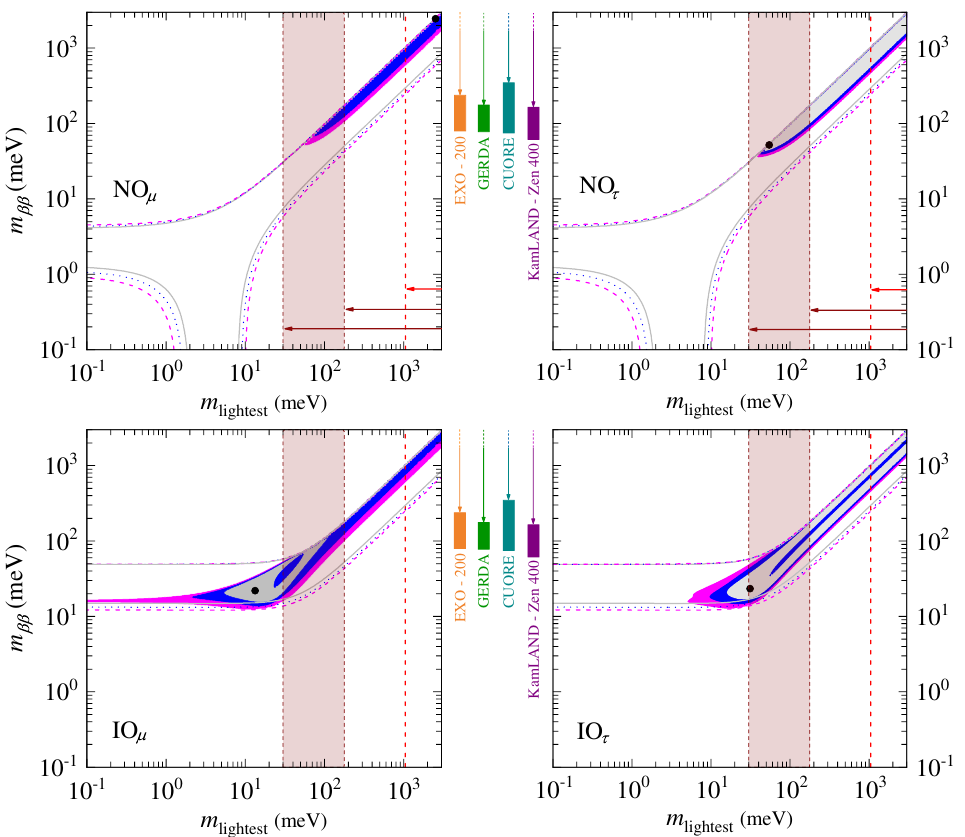
Figure 7 . Allowed ( m lightest , m ββ ) regions for NO (upper panels) and IO (lower panels). The colour code is the same in figures 5 and 6. The solid (dotted) [dashed] lines delimit the 1 σ ( 2 σ ) [ 3 σ ] m regions allowed in the general unconstrained case. The vertical bars in between the panels ββ indicate the current m upper bounds from KamLAND-Zen 400 [41], GERDA [42], CUORE [43] ββ and EXO-200 [44] at 95%CL. The height of the bars reflects the uncertainties in the nuclear matrix elements relevant for the computation of the decay